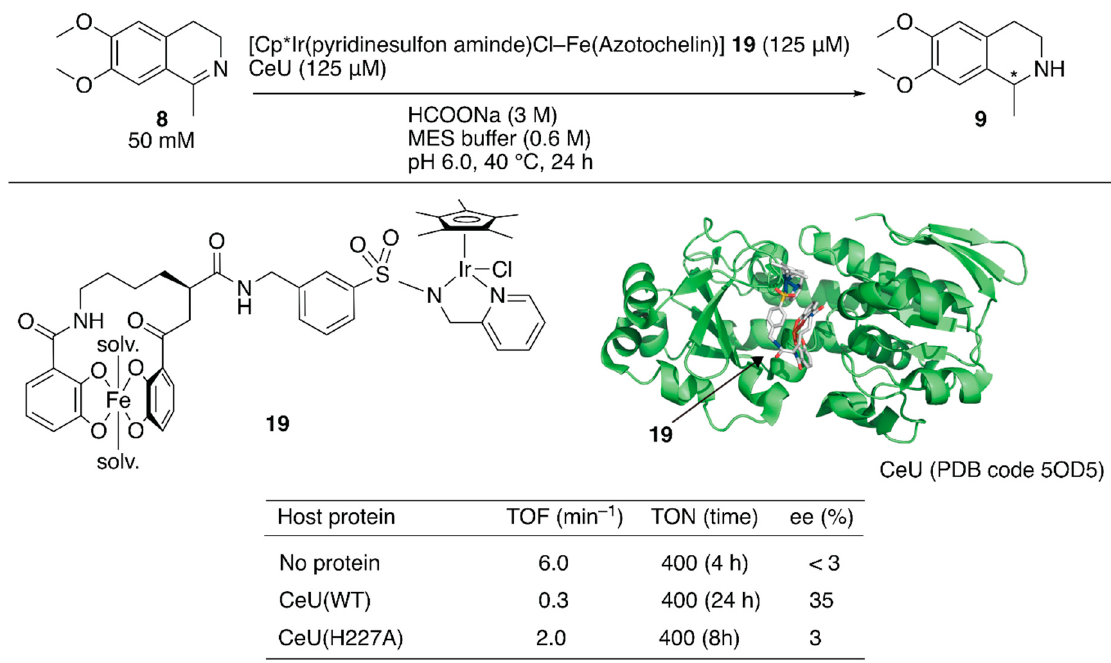
Figure 3. Transfer hydrogenation of an imine catalyzed by an artificial transfer hydrogenase possessing a reversibly bound iridium cofactor. Adapted from [41].